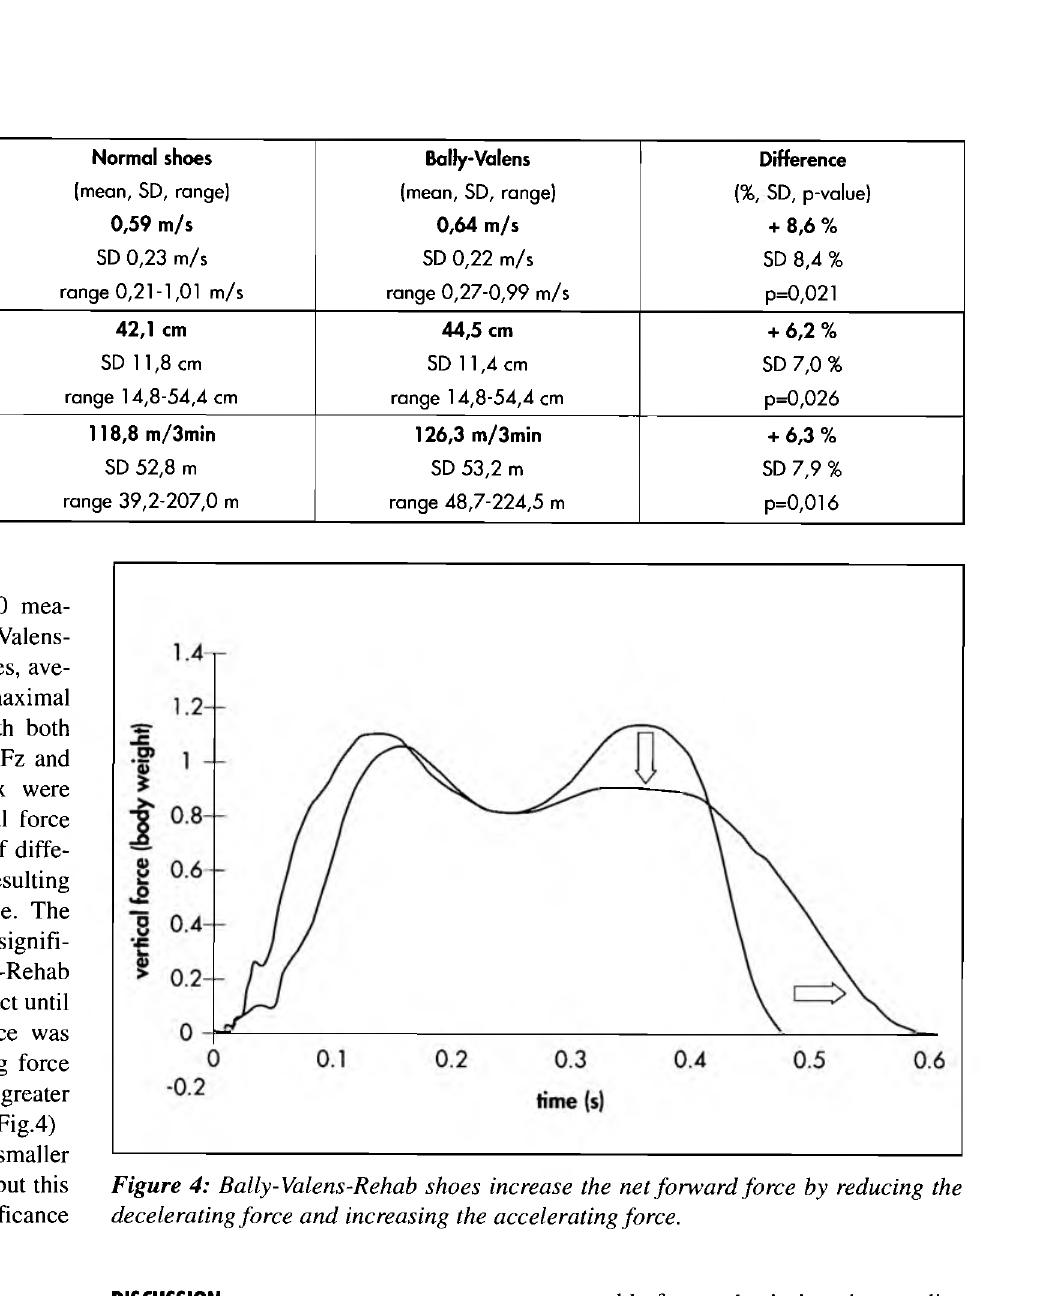
Figure 4: Bally-Valens-Rehab shoes increase the net forward force by reducing the decelerating force and increasing the accelerating